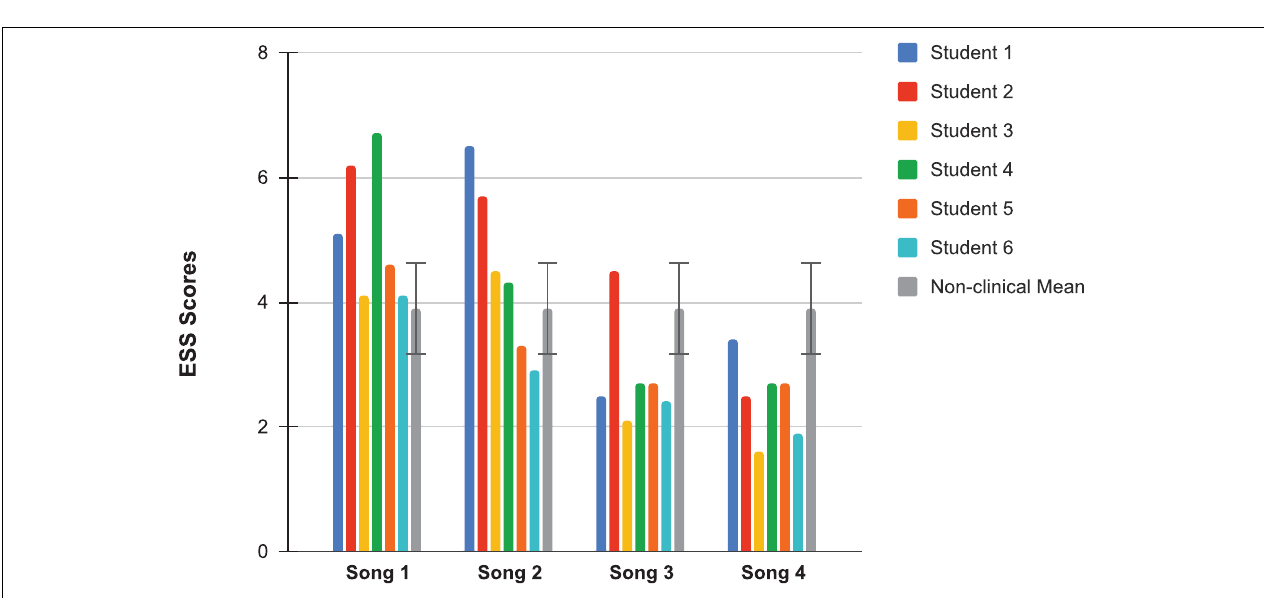
FIGURE 9 | Kenny Music Performance Anxiety Inventory scores for seven vocal students (Juncos et al., 2017) showing scores from the baseline period to post-treatment, 1- and 3-month follow-up points, also with the mean for musicians under age 30 (93.5), standard deviation bars ( SD = 39.1; Kenny et al., 2012), and the recommended clinical cutoff score (105; Ackermann et al., 2014).